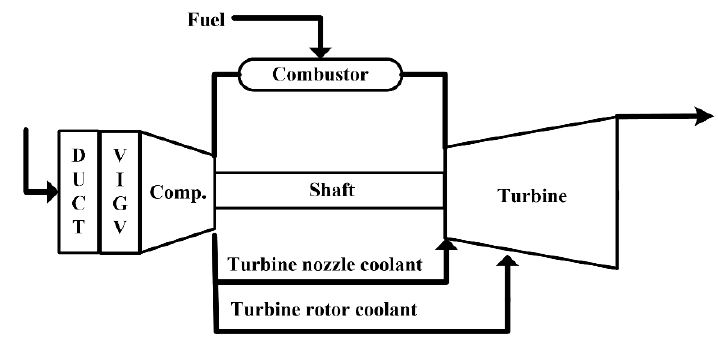
Figure 1. Structure of the virtual gas turbine.